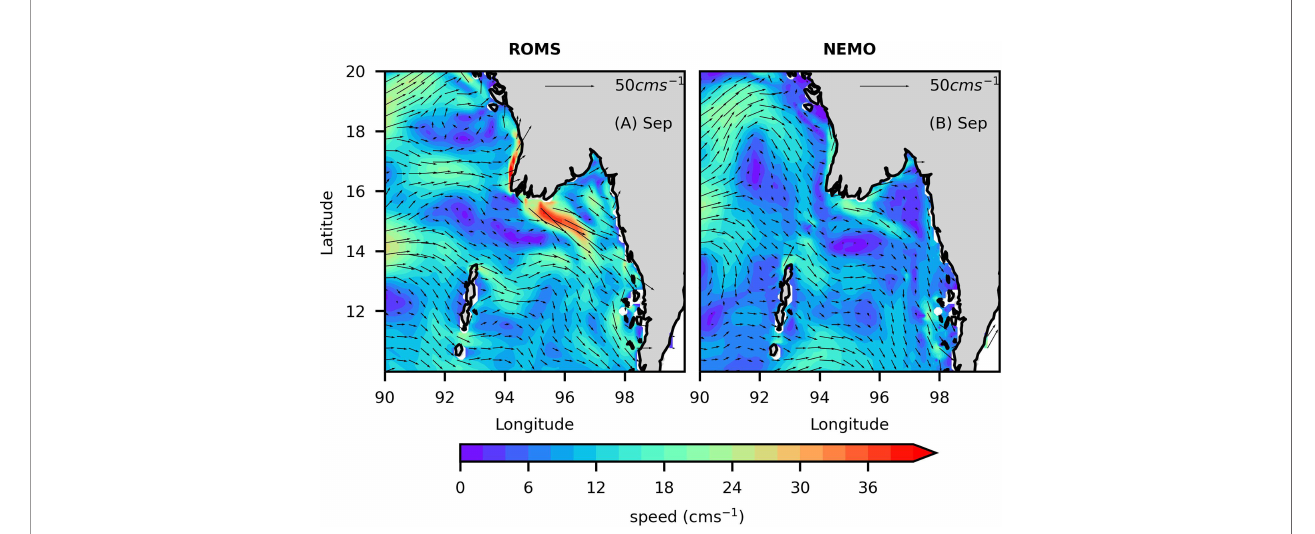
FIGURE 6 | Comparison of the spatial distribution of climatology of surface currents from IRFullW (left panel) and GLOBAL-REANALYSIS-PHY-001-030 (right panel) for the month of